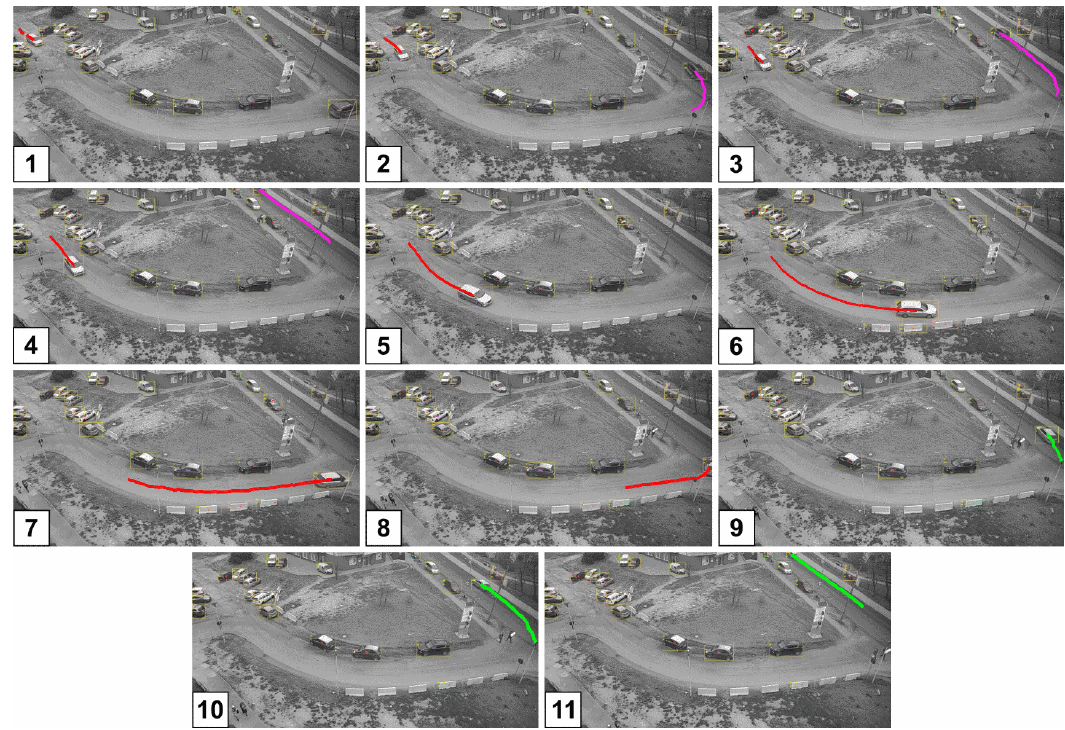
Figure 6. Example of single camera tracking. Images 1–11 present subsequent snapshots of the recording with two vehicles tracked. The first vehicle is visible on frames 1–4, the second one on all the snapshots. On snapshot 9 the vehicle is incorrectly identified as a new one.